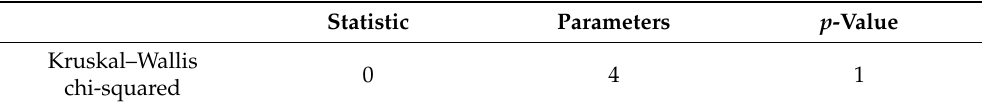
Table 4. Kruskal–Wallis test of the simulated portfolios’ returns.